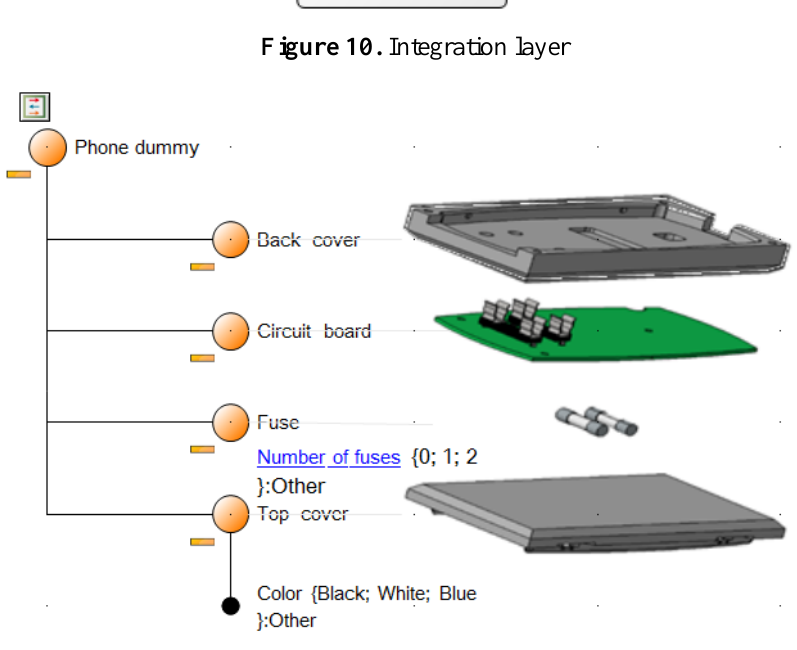
Figure 11. Asset layer, product model